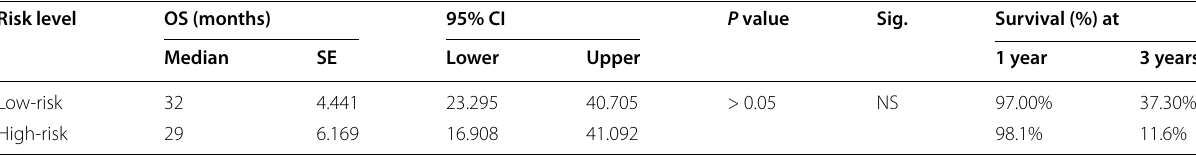
OS , Overall survival, NS nonsignificant, CI Confidence interval